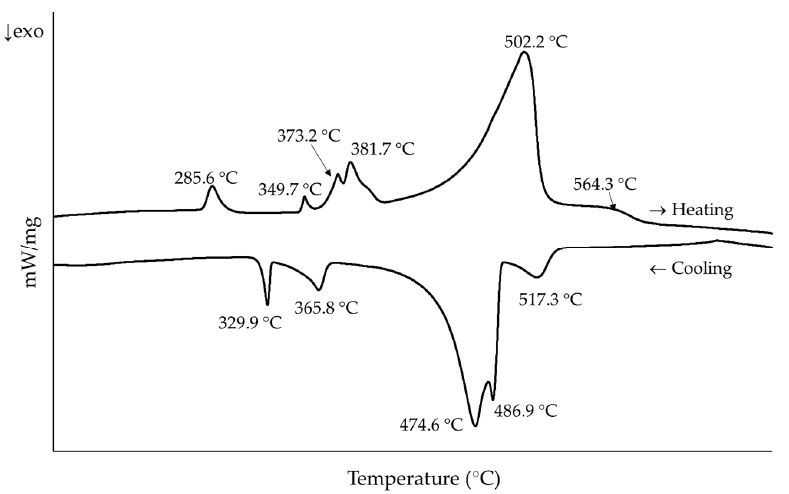
Figure 1. DSC curves for the as-cast sample. Peak temperatures during heating were considered for the thermal treatment selection of the samples. the thermal treatment selection of the samples.